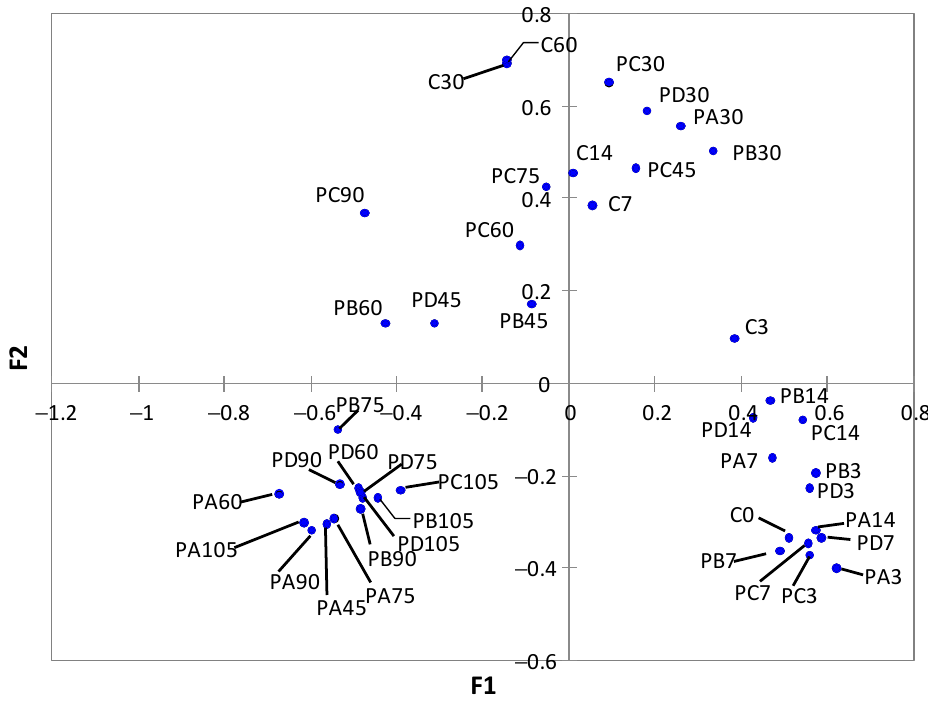
Figure 2. Results obtained after principal coordinates analysis of cod samples from trial 2 according to bacterial diversity data at genus level at different days of refrigerated storage. C, controls. Treatments: PA (300 MPa, 8 min, 50 °C); PB (600 MPa, 4 min, 50 °C); PC (600 MPa, 8 min, 22 °C); PD (600 MPa, 8 min, 50 °C).